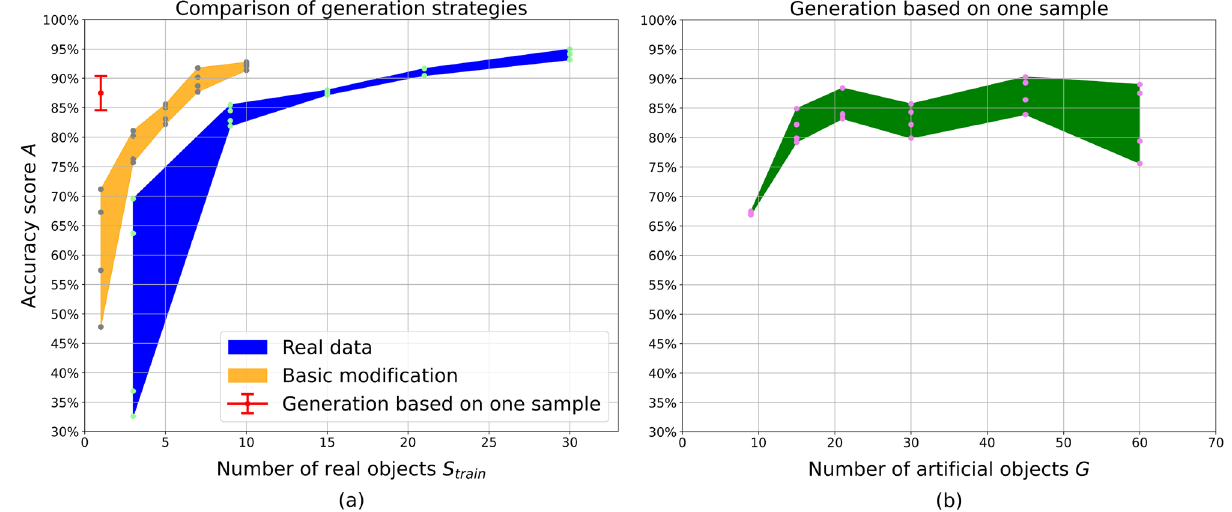
Figure 5. Dependency of modeling clay classification accuracy A on the amount of data provided for training. ( a ) Comparison between training on real data and generated images with a different number of real samples S train . ( b ) Training on the artificial images generated based on one experimentally scanned